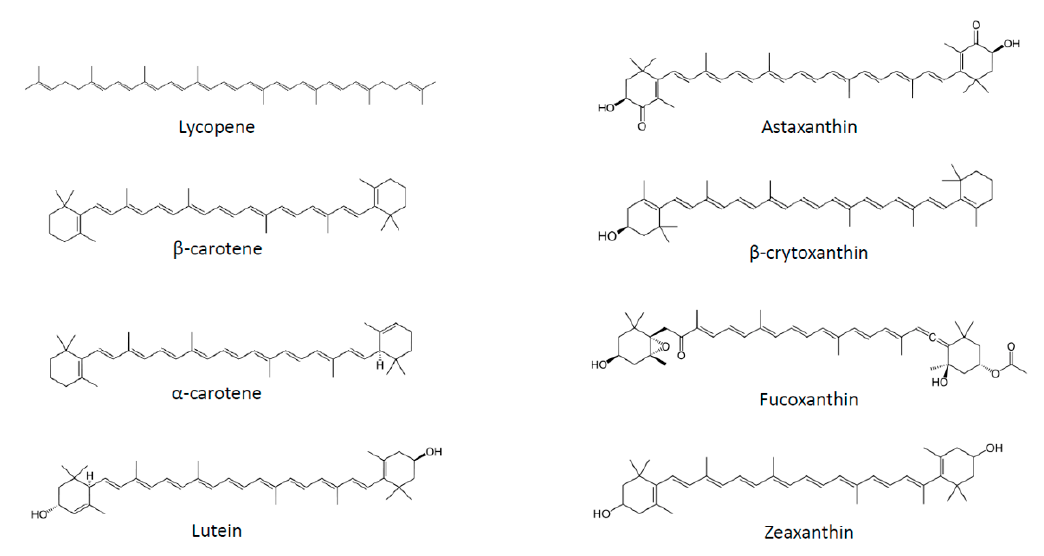
Figure 1. Chemical structures of the main carotenoids.